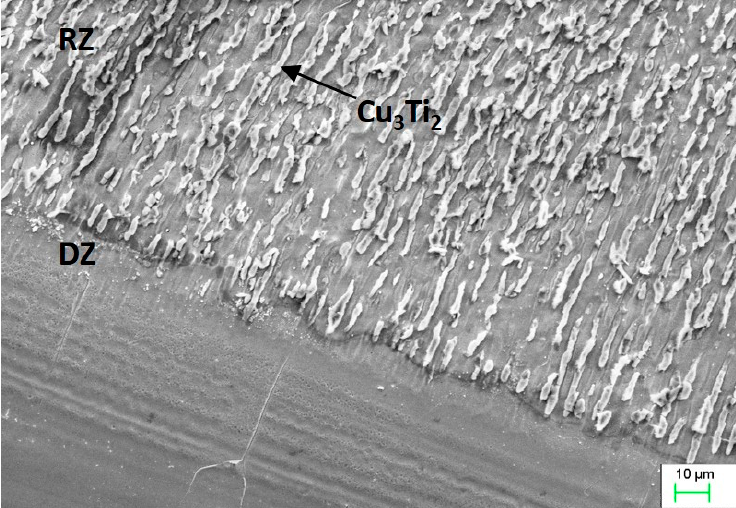
Figure 8. Scanning electron microscopy (SEM) image showing the microstructure of copper after Ti alloying.